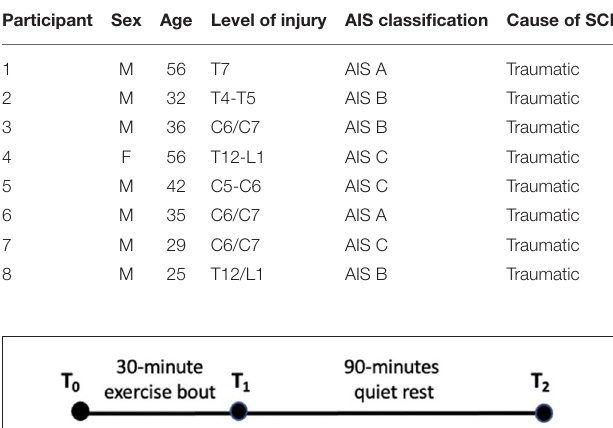
TABLE 1 | Demographic information of the sample ( n = 8).